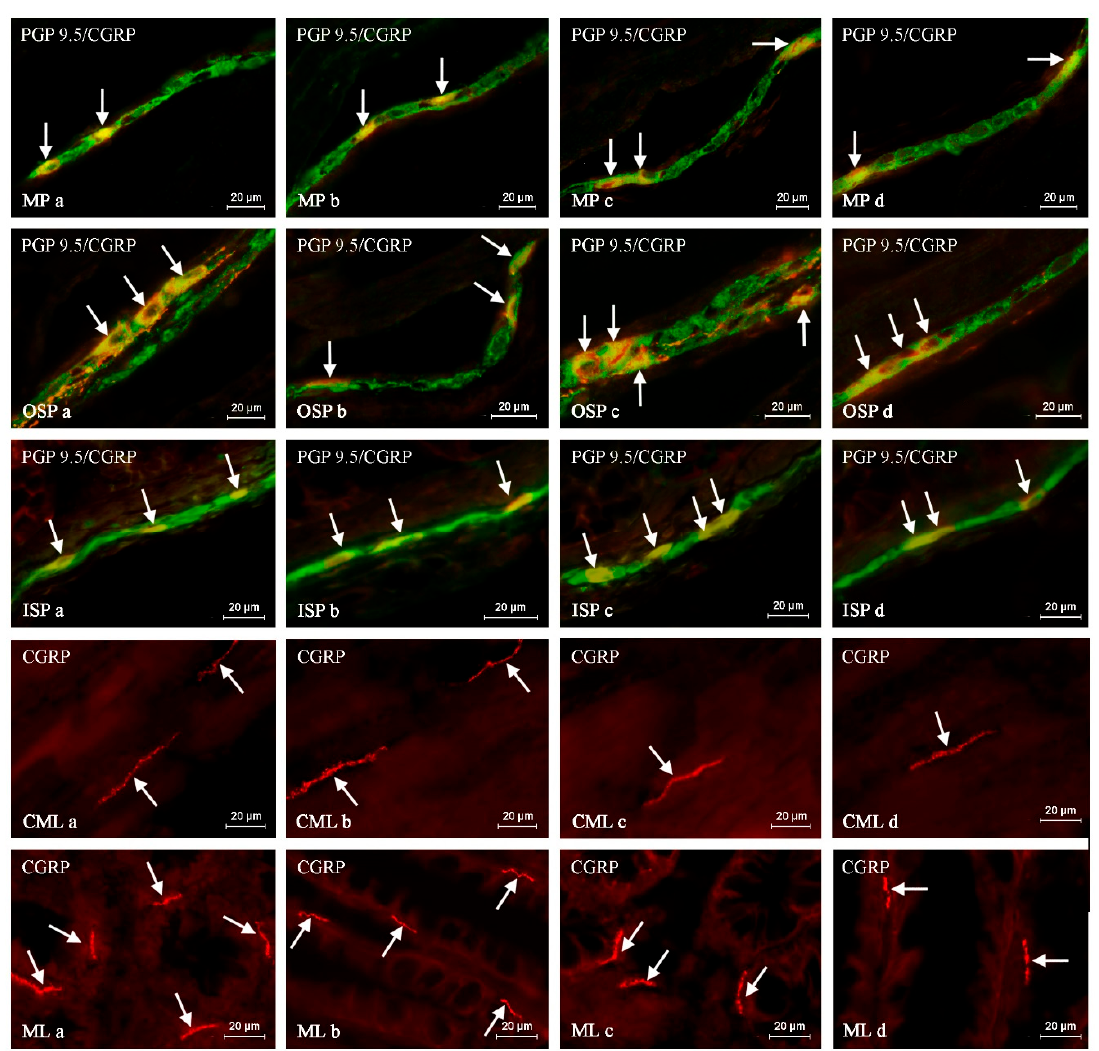
Figure 1. The representative images of the distribution of calcitonin gene-related peptide (CGRP) in the nervous structures of the myenteric plexus (MP), outer submucous plexus (OSP), inner submucous plexus (ISP), circular muscle (CML) and mucosal (ML) layers of the porcine descending colon under physiological conditions in young females ( a ), young males ( b ), adult females ( c ) and adults males ( d ). Images are composites of merged photographs taken separately from green (pan-neuronal marker PGP 9.5) and red (CGRP) fluorescent channels. Nervous structures immunoreactive to CGRP are indicated by arrows.